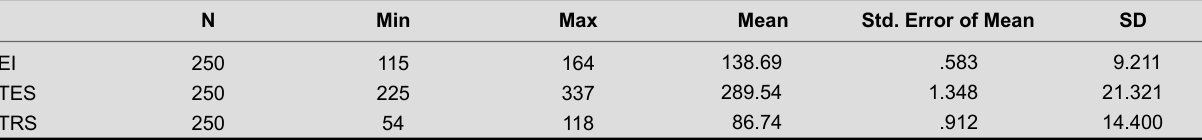
EI, Self-Reported Teacher Effectiveness (TES) and Student-Rated Teacher Effectiveness (TRS)